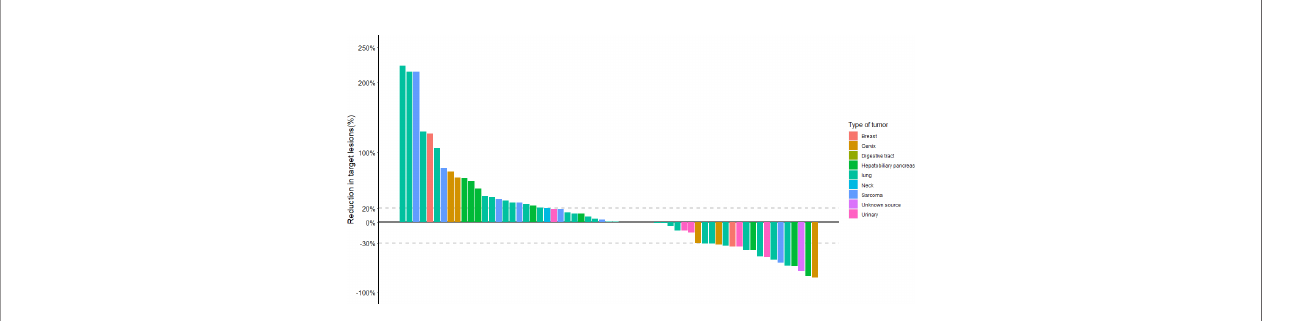
FIGURE 2 | Waterfall plot showing best responses by immune-related response criteria. The best change from baseline as the sum of longest target lesion diameter per patient is